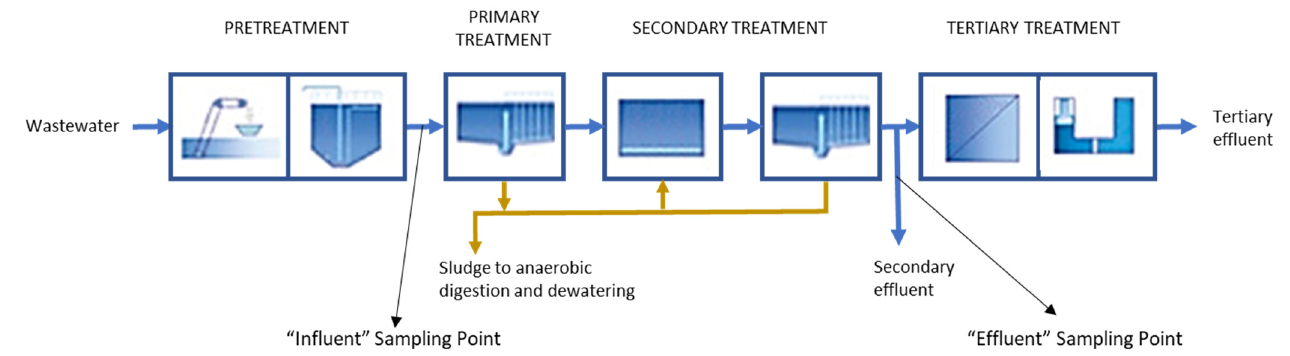
Figure 1. Sampling points in the water line of the Benidorm WWTP (process images adapted from EPSAR [24]).